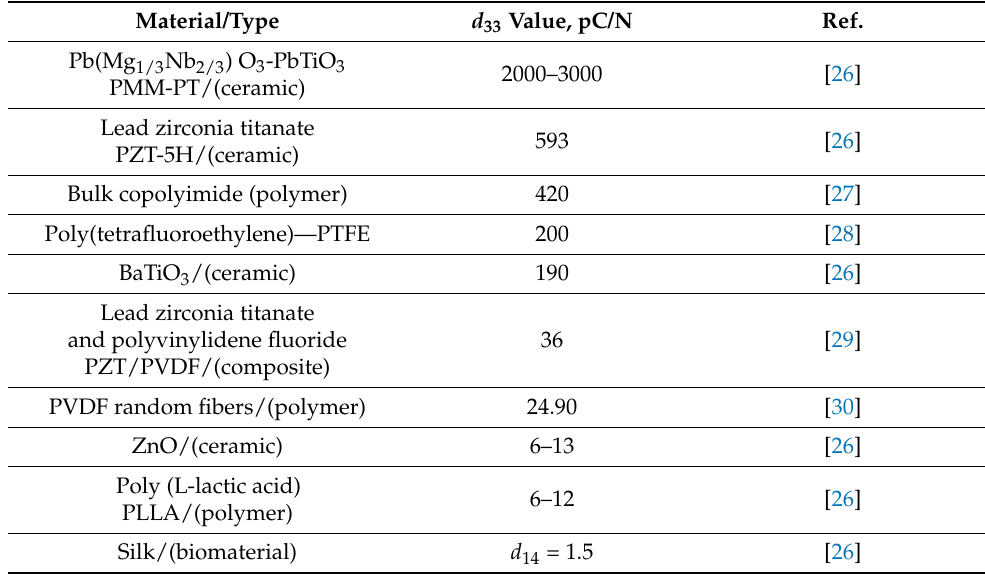
Table 1. Piezoelectric coefficient values for different